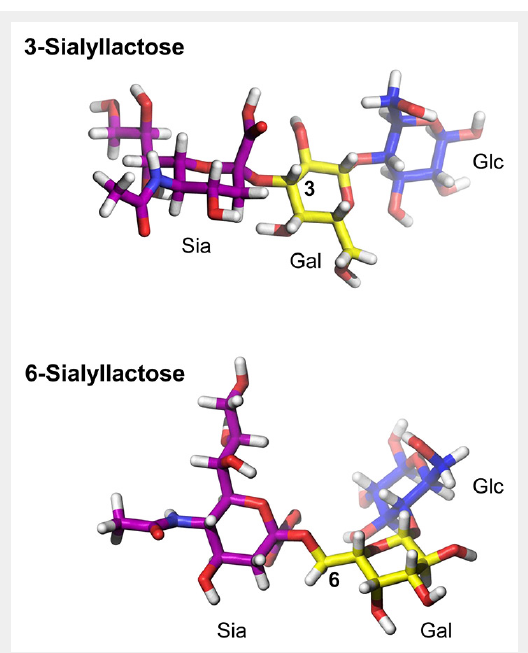
Milk oligosaccharide biosynthesis. Oligosaccharides are represented by the symbolic nomenclature of the Functional Consortium for Glycomics (see www.functionalglycomics.org). The disaccharide lactose (in orange frame) is produced by the β1–4 galactosyltransferase / α-lactalbumin complex. Lactose is further modified by elongation with galactose(β1–4)N-acetylglucosamine disaccharides and addition of fucose and sialic acid. 2FL = fucosyl(α1,2)lactose; 3FL = fucosyl(α1,3)lactose; 3SL = sialyl(α2,3)lactose; 6SL = sialyl(α2,6)lactose